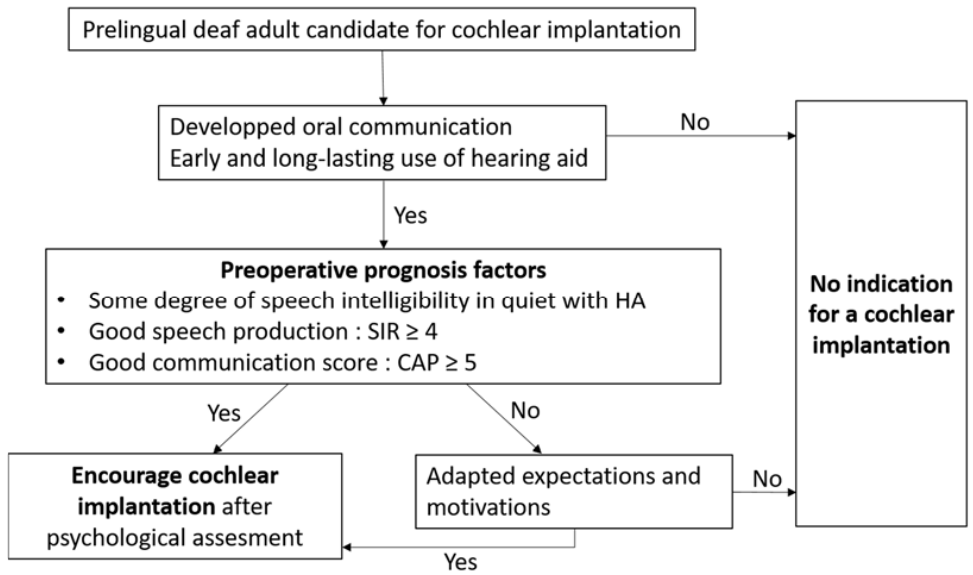
Figure 4. Decision algorithm for cochlear implantation in the case of an adult patient with prelingual severe-to-profound hearing loss. HA: hearing aid; SIR: Speech Intelligibility Response; CAP: Com- munication Auditory Performance. Communication Auditory